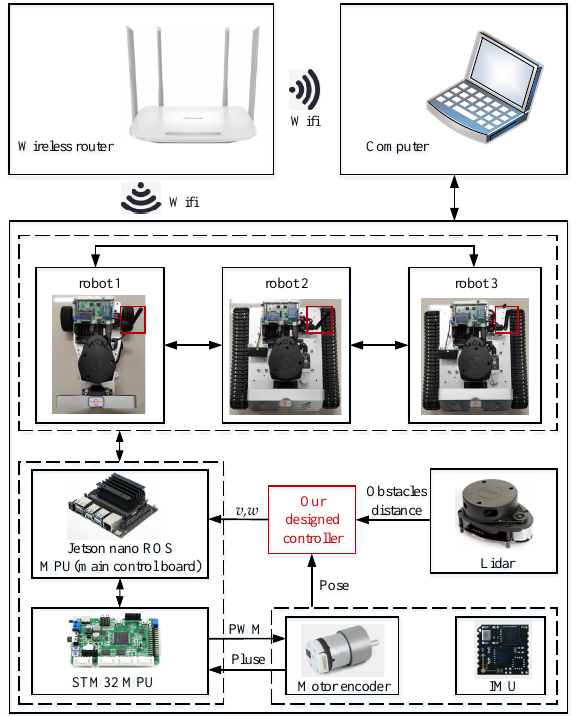
Figure 6. Multiple nonholonomic mobile robots experiment platform.